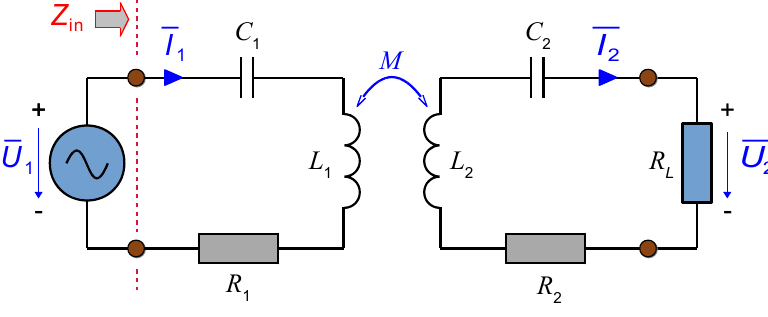
Figure 2. Series-series compensation topology.